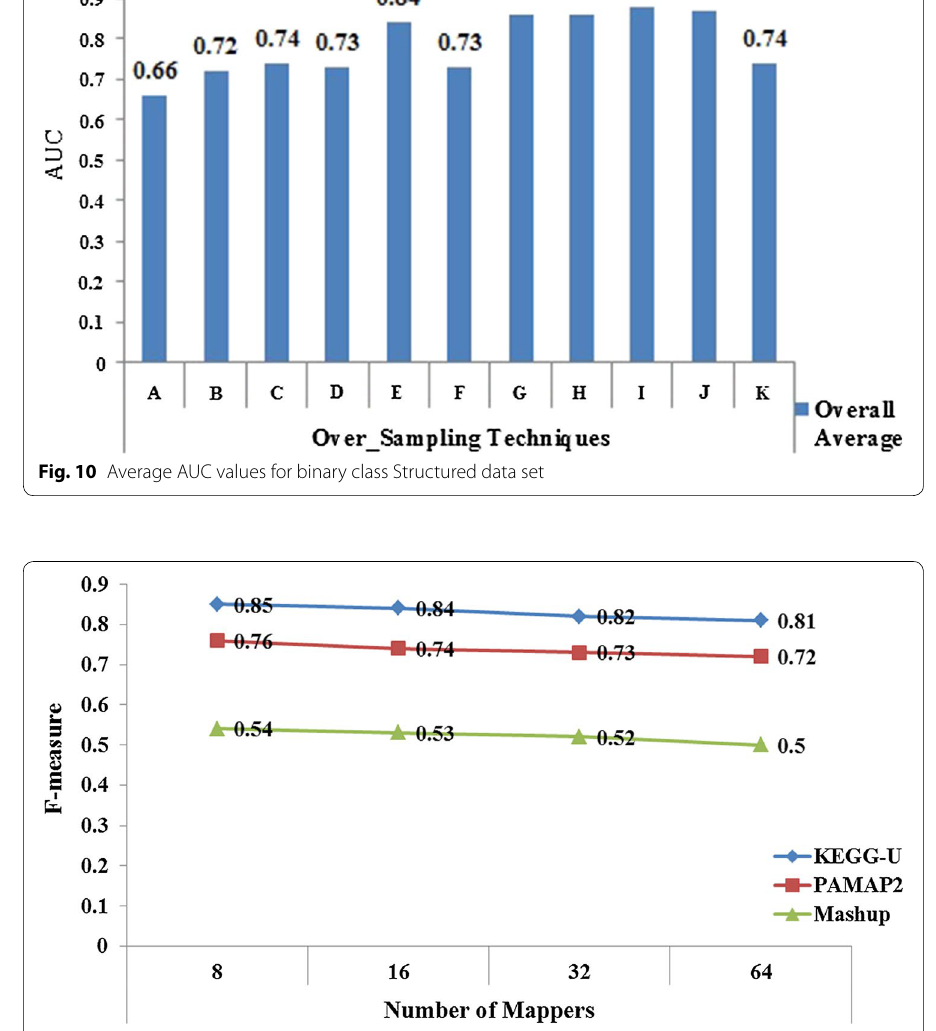
Binary‑class structured data sets